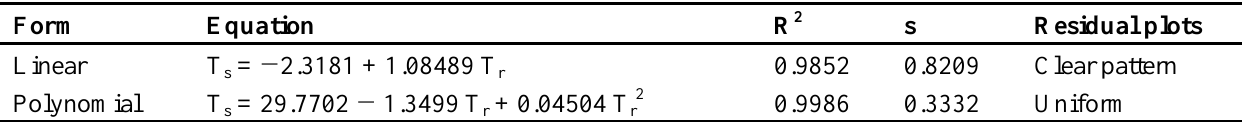
Table 5. The calibration equations and statistics of TROTEC BP-20 infrared thermocouple within the ranged from 20  to 35  C.